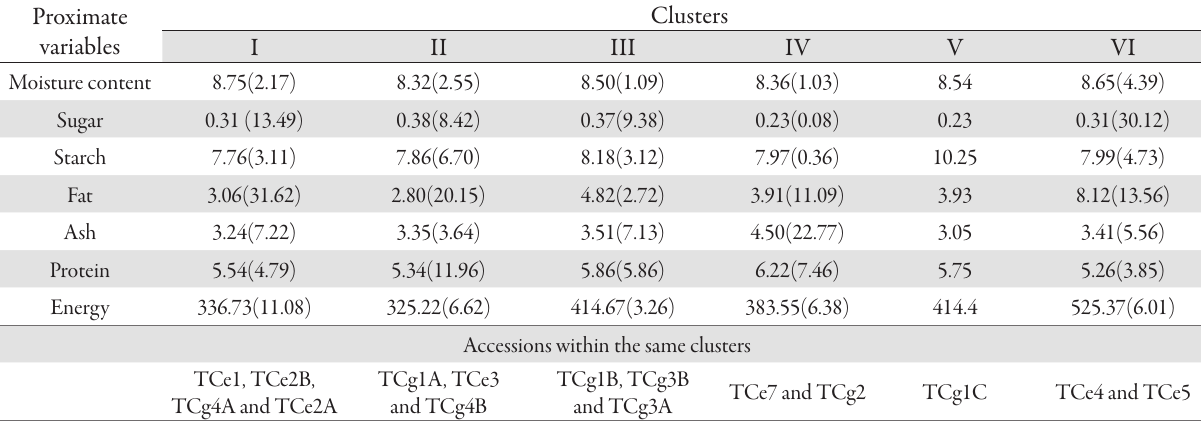
Tab. 4. Intra-cluster variability of the 15 accessions of Canavalia spp . based on some quantitative proximate descriptors